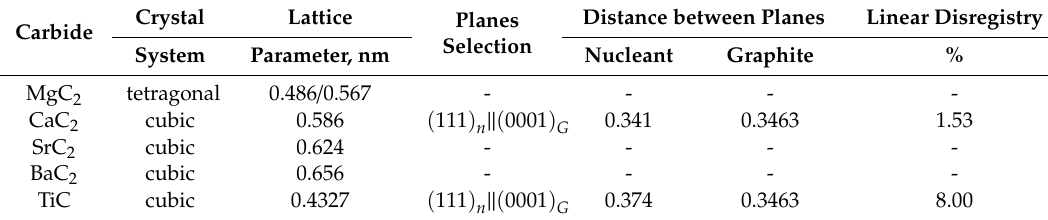
Table 4. Crystallographic properties of some